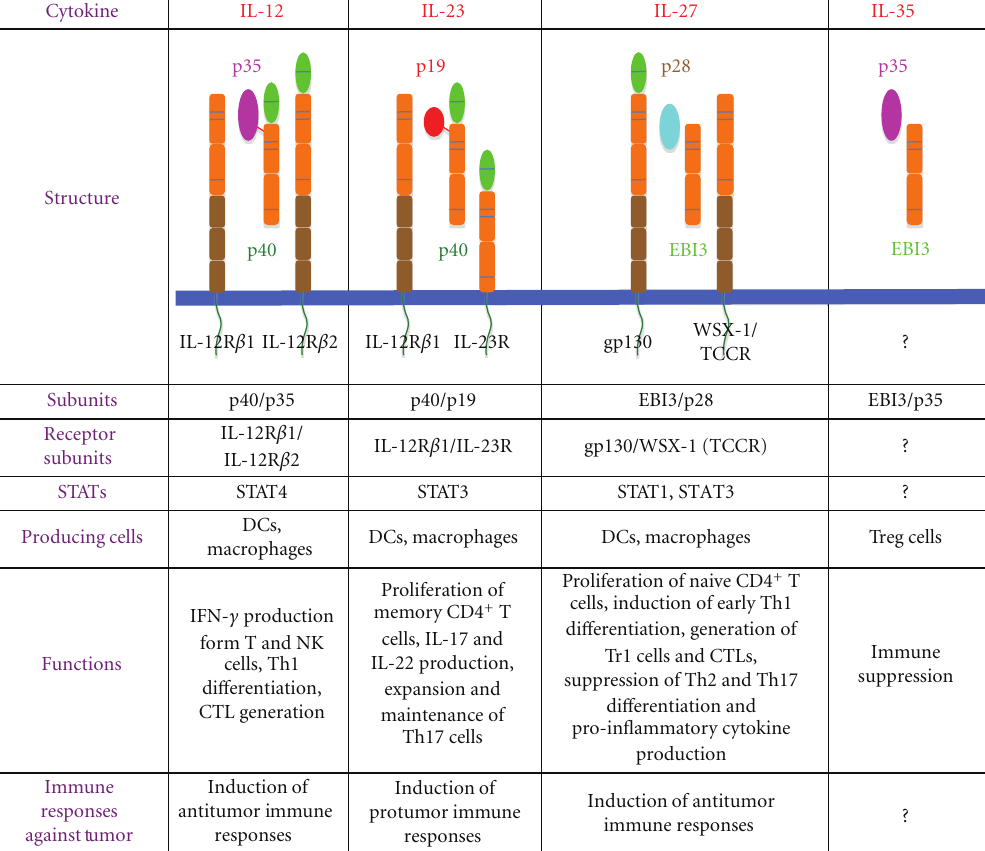
Figure 1: Molecular characterization of the IL-12 family cytokines, IL-12, IL-23, IL-27, and IL-35. IL-12 induces IFN- γ production by NK and T cells and di ff erentiation to Th1 cells. IL-23 induces IL-17 production by memory T cells and expands and maintains inflammatory Th17 cells. IL-27 induces the early Th1 di ff erentiation and generation of IL-10-producing Tr1 cells. In addition, these cytokines induce distinct immune responses to tumors. IL-12 activates STAT4 and enhances antitumor cellular immunity through IFN- γ production. IL-27 activates STAT1, as does IFN- γ and STAT3 as well, and enhances antitumor immunity by augmenting cellular and humoral immunities. In contrast, although exogenously overexpressed IL-23 enhances antitumor immunity via memory T cells, endogenous IL-23 promotes protumor immunity through STAT3 activation by inducing inflammatory responses including IL-17